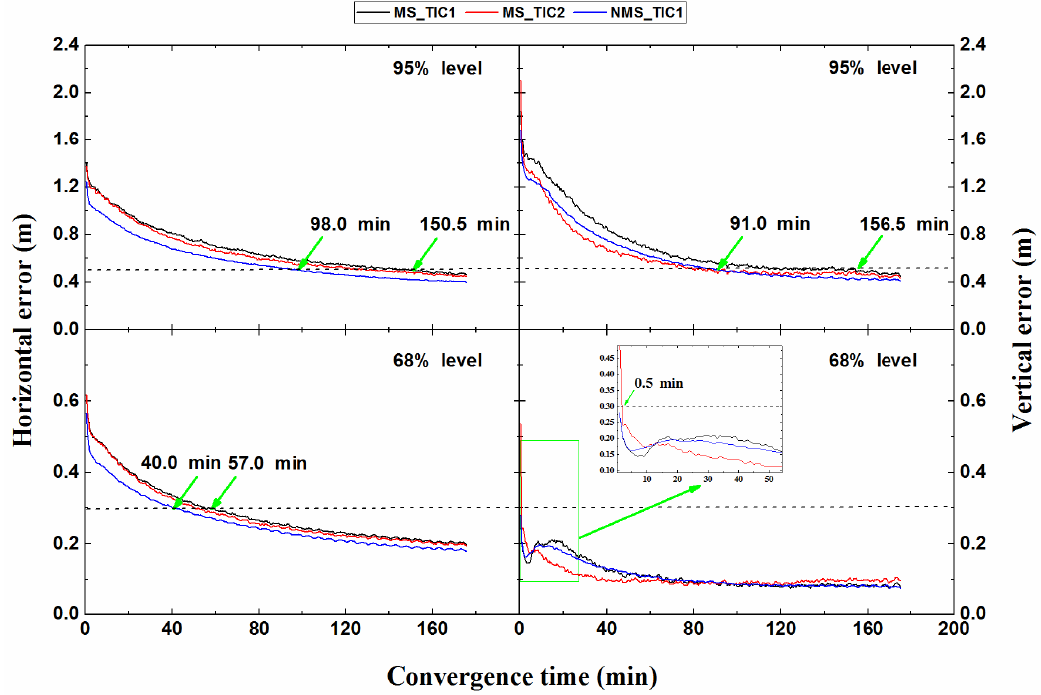
Figure 4. The GPS kinematic SF PPP convergence performance in different constraint schemes during the MS and NMS periods.